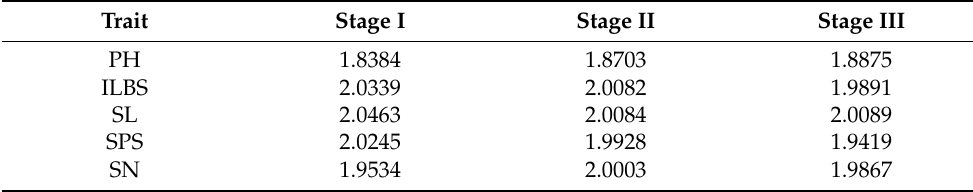
Table 3. Genetic Diversity Index of wheat traits at different sowing dates ( H ’).